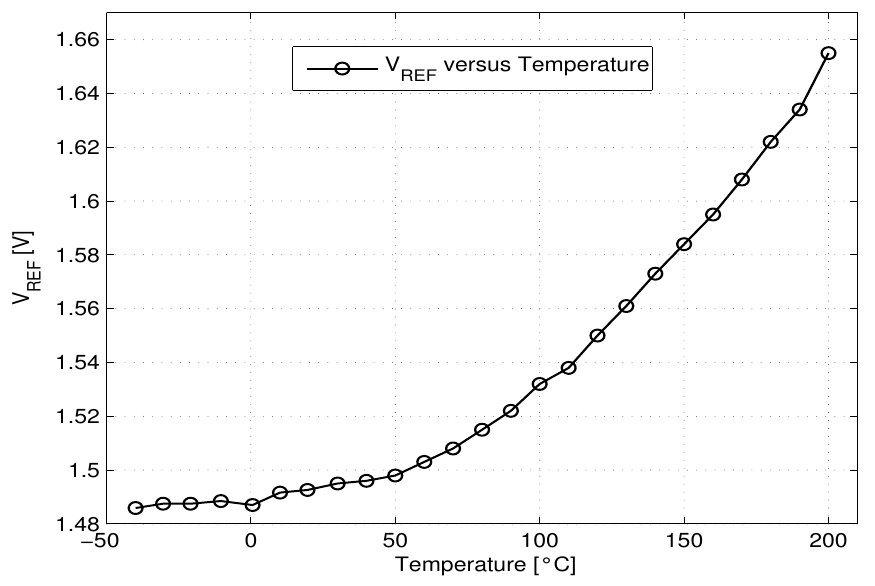
Figure 8. Measured voltage reference V